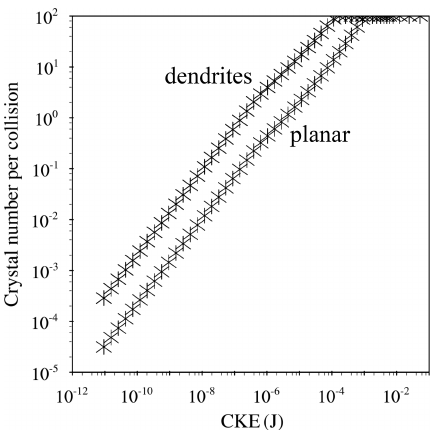
Figure 1. The number of fragments per collision as a function of initial collisional kinetic energy (CKE). The ice habit is assumed to be dendrites when the temperature ( T ) is between − 12 and − 17 ◦ C and is assumed to be spatial planar when − 40 ◦ C < T < − 17 ◦ C and − 12 ◦ C < T < − 9 ◦ C, following Phillips et al.